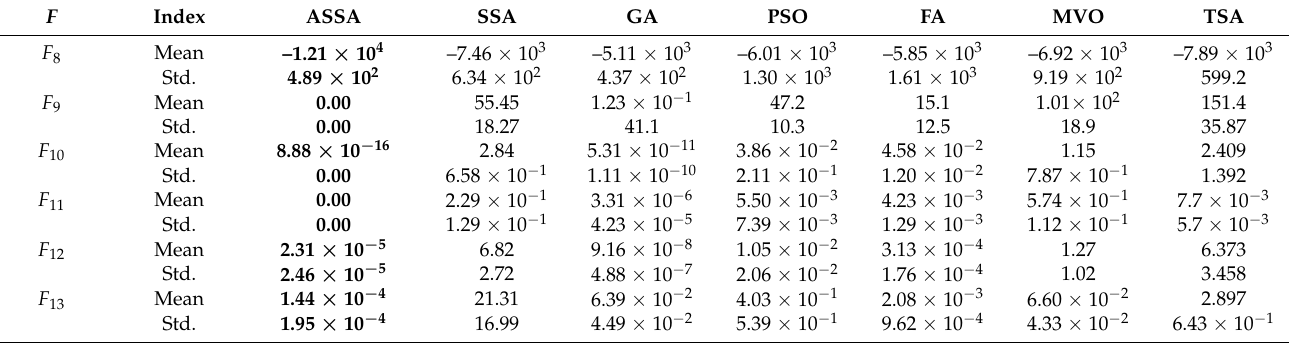
Table 5. Comparison of different methods in solving multimodal test